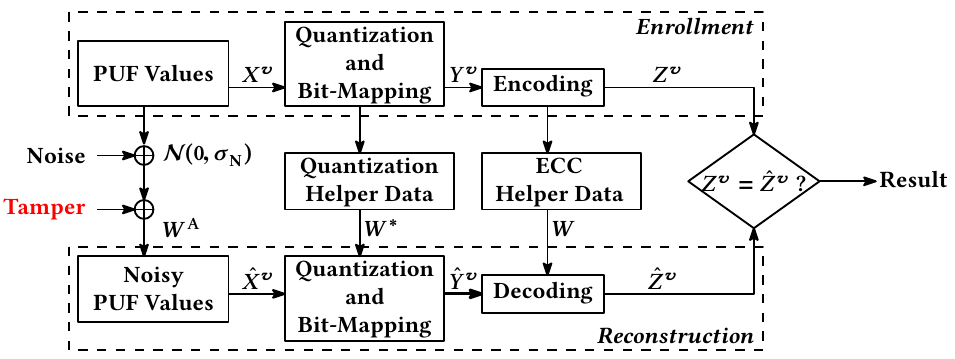
Figure 1: PUF system model with enrollment and reconstruction. Y is the quantized PUF response and Z the secret bit sequence. Added noise is denoted as (ˆ ·